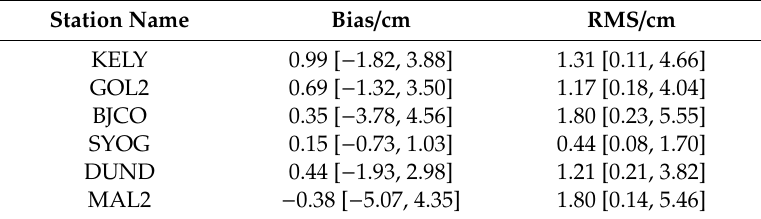
Figure 5. ZTD RMS time series of the ( a ) KELY, ( b ) GOL2, ( c ) BJCO, ( d ) SYOG, ( e ) DUND and ( f ) MAL2 stations derived from the MERRA-2 data from 2015 to 2017 (the content in parentheses indicates the latitude, longitude and altitude of the IGS station). Table 2. Descriptive statistics of the daily average bias and RMS of six representative IGS stations in